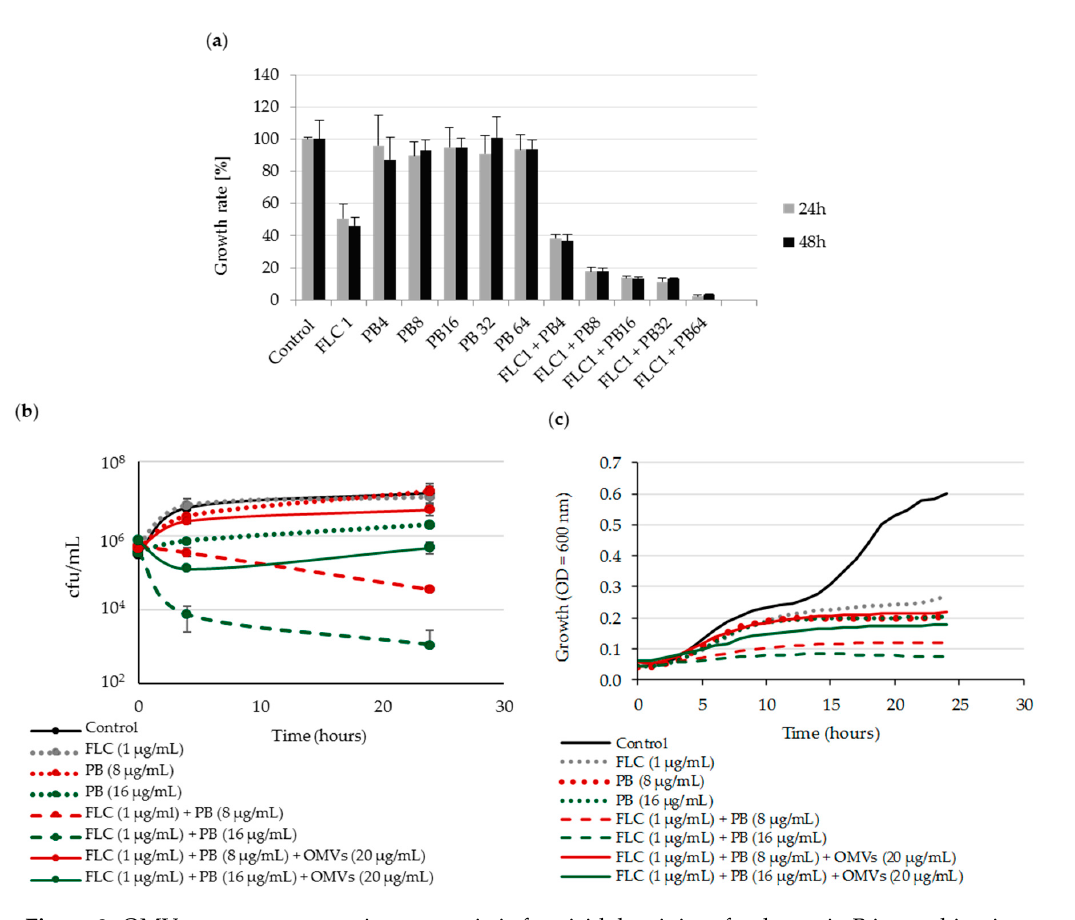
Figure 3. OMVs protect yeast against synergistic fungicidal activity of polymyxin B in combination with fluconazole: ( a ) Synergistic activities determined by checkerboard assay; ( b ) time-kill assay; ( c ) 24 h growth-curve kinetics for C. albicans incubated with drug alone and drug in combinations with or without OMVs. The kinetics were measured using Varioskan™ LUX reader with measurements at 1 h intervals. The data for experiments (a,b) show means ± SD from two independent experiments carried out in triplicate; the data for experiment (c) show mean values from two independent repetitions carried out in duplicate; for better readability, SDs were not included.